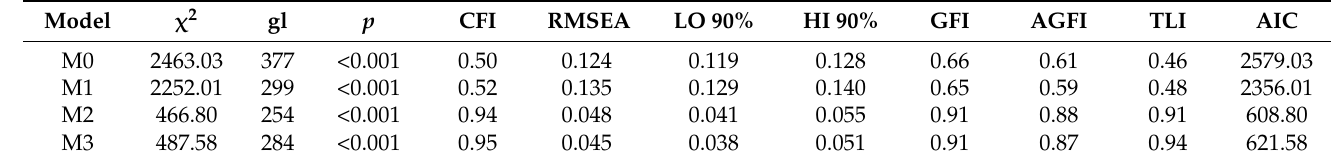
Table 2. Fit indices of the CFA of the four models of the Spanish adaptation of the SPFL scale.